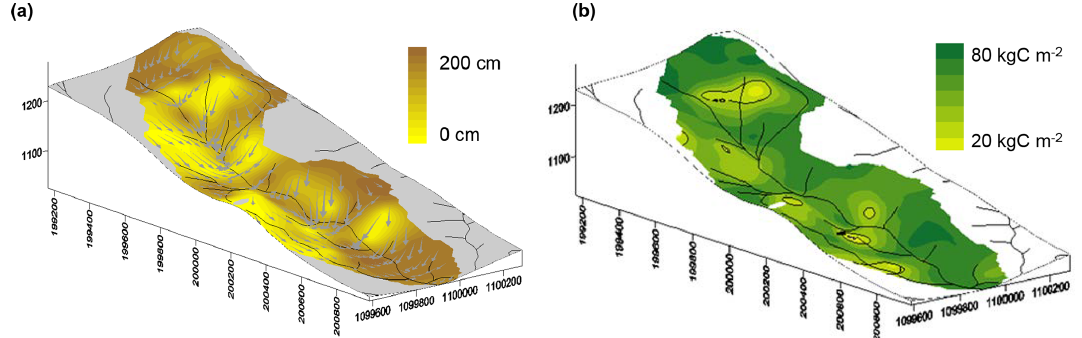
Figure 4. (a) Map of the thickness of the allophanic soil material layer (in centimetres) in the Aquiares watershed; the fine grey arrows show directions and steepness of elevation gradients: longer arrows indicate steeper slopes. (b) Map of SOC stocks (kgCm − 2 ) in the upper 2m of soil. Altitudes above sea level are in metres; x and y axes show UTM